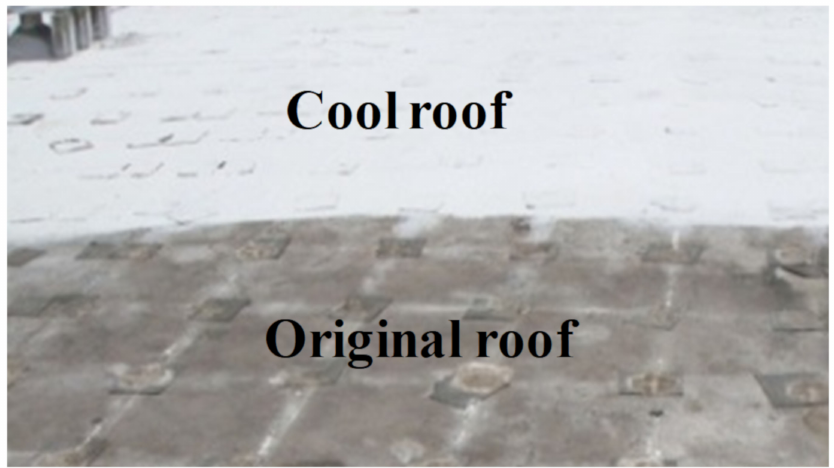
Figure 1. Experimental roof of a residential building in